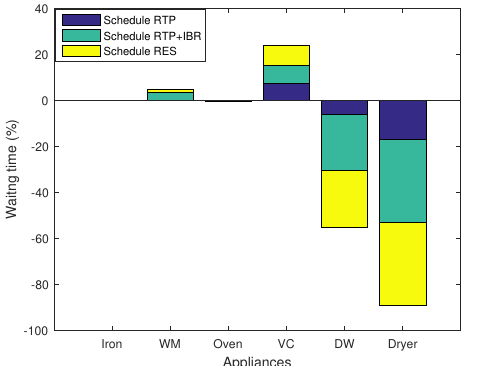
Figure 12. Appliances delay time behavior for scheduled with RTP, RTP+IBR and RES.